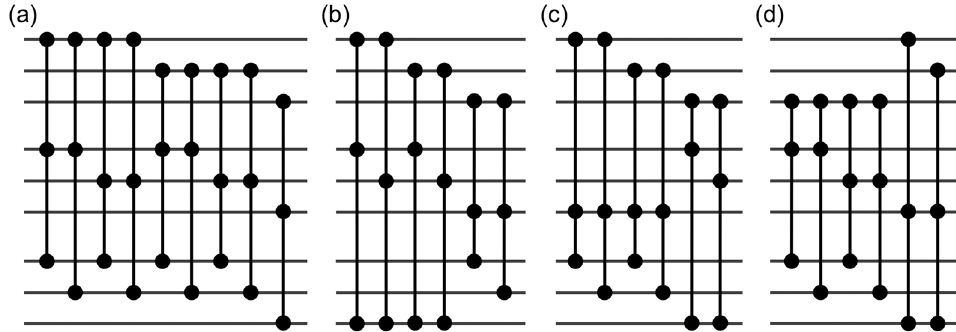
FIG. 5. The round-robin circuit for CCZ between three code blocks each with three active qubits (e.g., qubits 1, 3, 5 for a 5 0 -qubit code block and qubits 5, 6, 7 for a 7-qubit code block). Idle code qubits are omitted. The circuit is broken into four pieces (a) – (d), each of which is 2-transversal, and therefore an appropriate error correction performed after each piece ensures pieceable fault tolerance (see text). This circuit design is quite versatile. For instance, this idea performs a CCZ on the 5 0 -qubit code (Sec. III D), on the 7-qubit code (Sec. IV B), and between 5 0 - and 7-qubit code blocks, among other possibilities (Sec. V). On some codes (see Sec. V for explicit conditions), including the 5 0 - and 7-qubit codes, replacing the CCZs with CCXs or CCYs will also implement logical CCX or logical CCY,